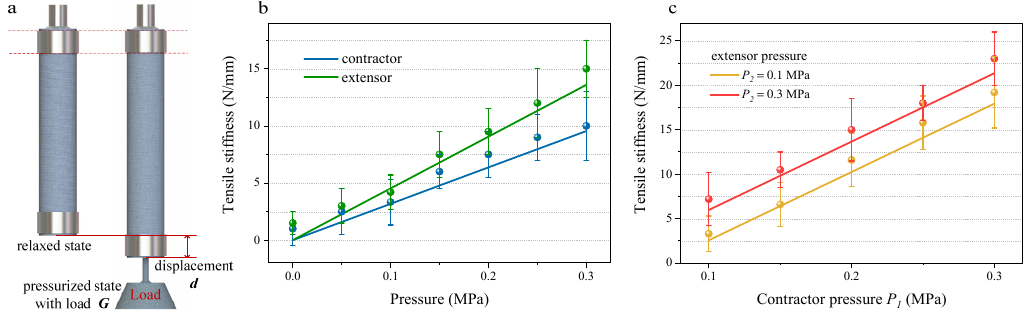
Figure 9. Tensile sti ff ness of the actuator. ( a ) Diagram of the method for testing the sti ff ness of the actuator. ( b ) The pressure-sti ff ness simulation and experiment result of independently pressurizing the extensor or contractor muscles of the actuator separately (scatter plots is the test results). ( c ) The actuator tensile sti ff ness simulation and experiment results of pressurizing the extensor and contractor muscles simultaneously (scatter plots is the test results).